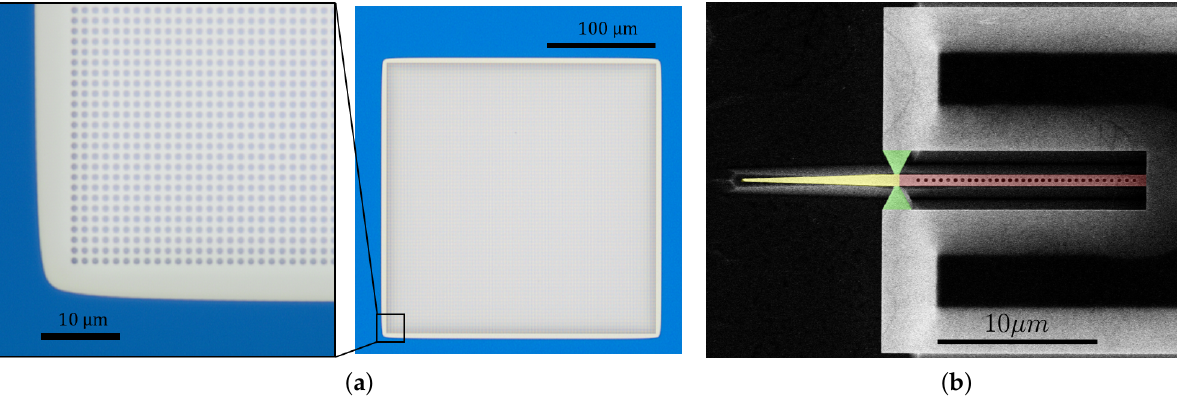
Figure 7. ( a ) Optical microscope image of the suspended square membrane. The blue color is from thin-film interference effects of the not suspended silicon nitride on silicon substrate. ( b ) Electronic microscope image of the suspended GaP OMC, in yellow, the inverse taper waveguide, clamping point in light green and the cavity in red. (Colors are